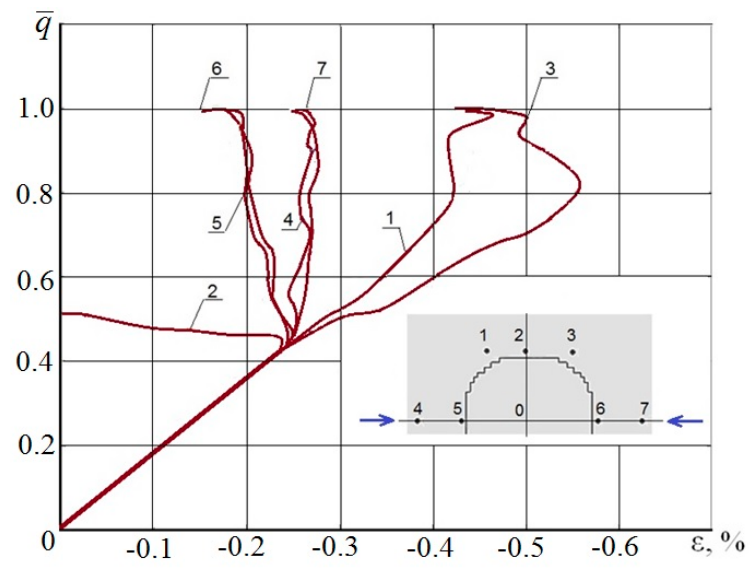
Figure 9. Strains in tested points near impact damage zone.